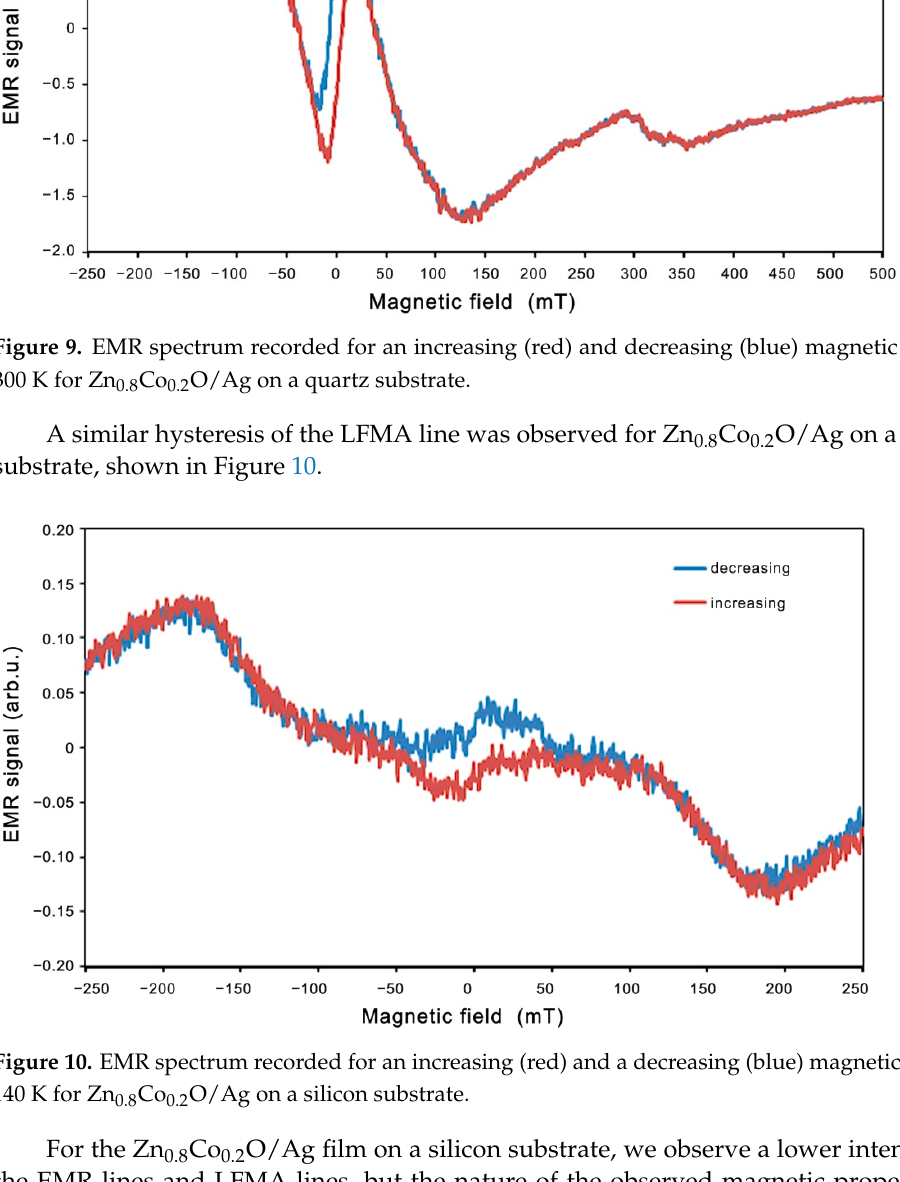
140 K for Zn 0.8 Co 0.2 O/Ag on a silicon substrate.